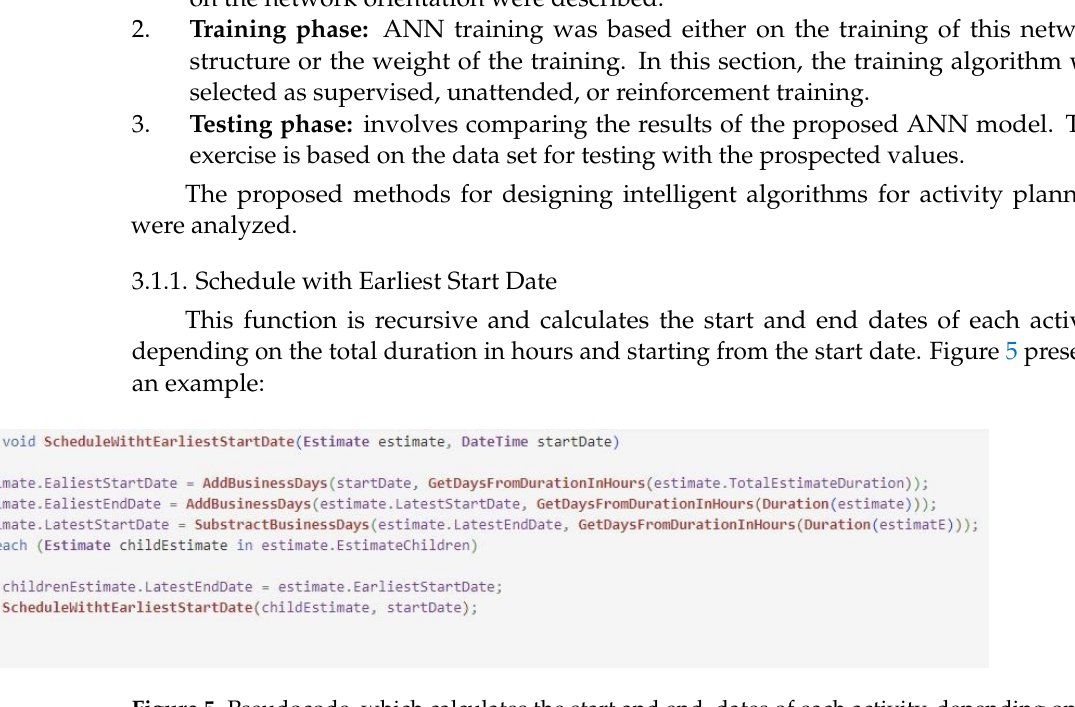
Figure 6. Pseudocode for calculating the duration in hours. 3.1.3. Calculate Total Estimate Duration This function calculates the estimated total hours for the duration of a service, being shown in Figure 7.